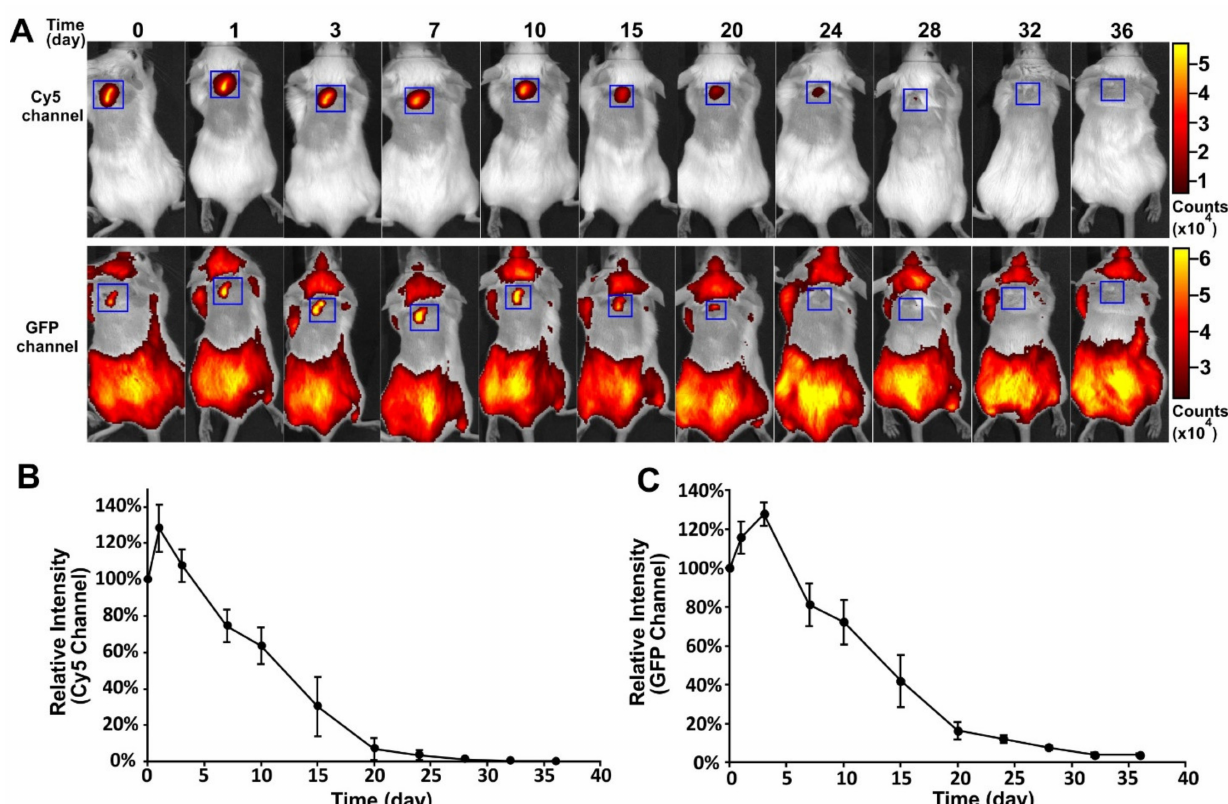
Figure 4. Release of Cy5-Q β particles from PLGA implants in vivo. ( A ) Fluorescence images of mice containing FITC-PLGA implants loaded with Cy5-Q β , showing the Cy5 channel (top) and GFP channel (bottom) at different time-points. Blue square shows implant location. Scale bar shows fluorescence intensity for all images in each channel. ( B ) Quantitative release profile (Cy5 channel) for the FITC-PLGA implants loaded with Cy5-Q β (Data are means ± s.d. for n = 4 mice per group). ( C ) Quantitative release profile (GFP channel) for the FITC-PLGA implants loaded with Cy5-Q β (Data are means ± s.d. for n = 4 mice per